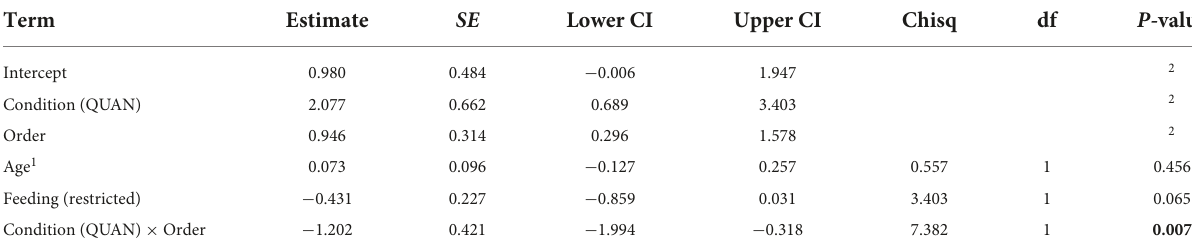
TABLE 4 Effects of condition, order, age, and feeding management on maximally reached delay durations (full model;